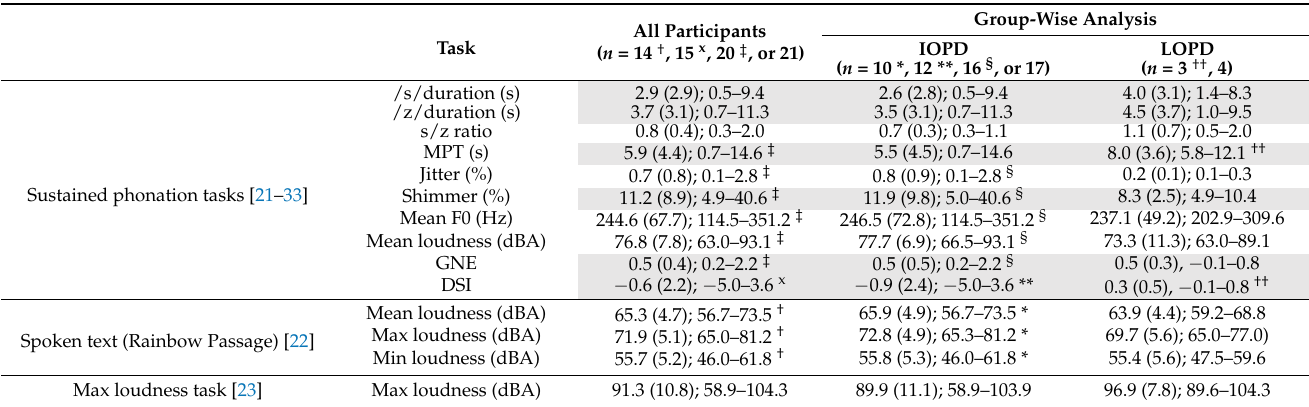
Table 4. Summary statistics for physiologic/acoustic data.